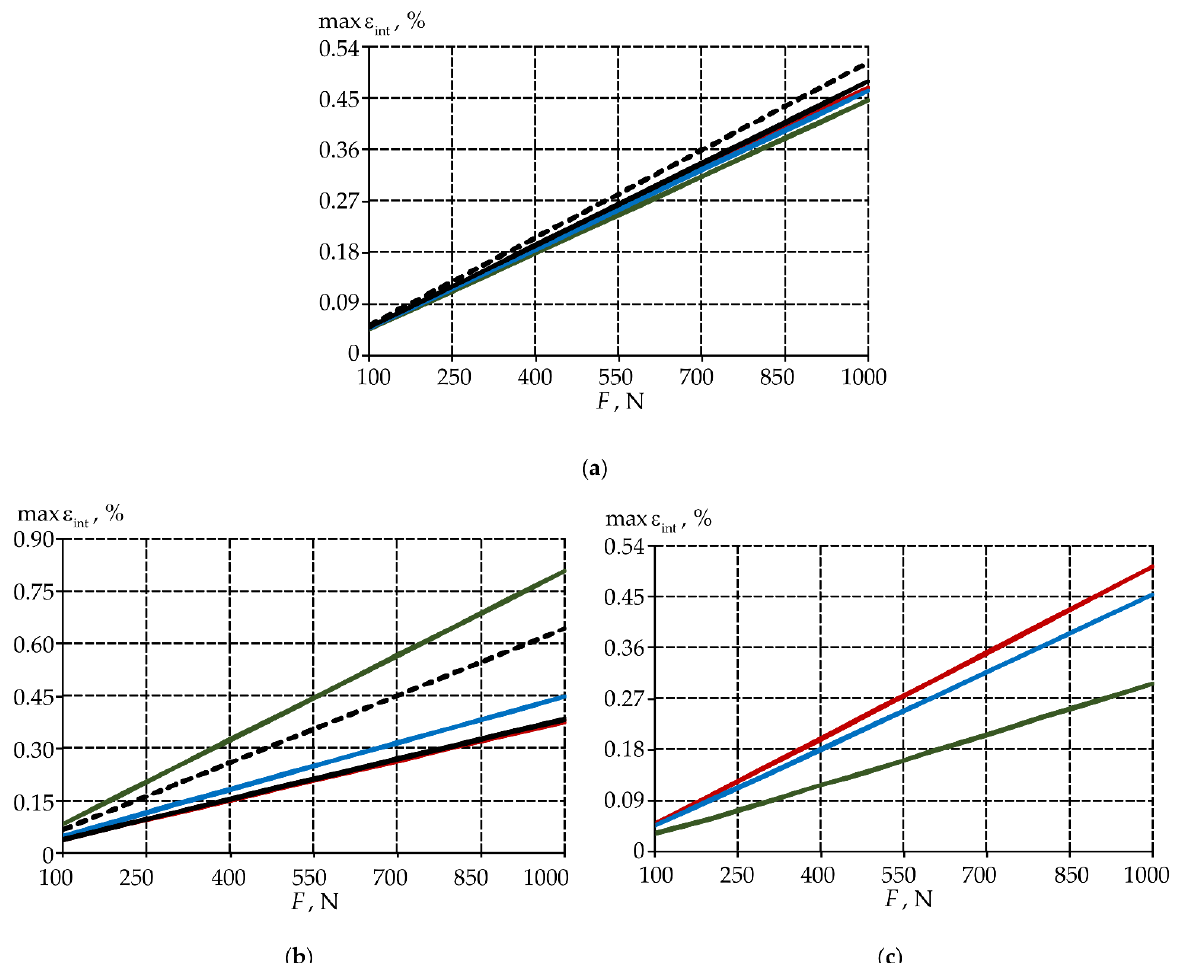
Figure 10. Dependence of the maximum values of the strain intensity of the biomechanical assembly on the load: ( a ) is enamel; ( b ) is dentine; ( c ) is inlay; black (solid line) is model without defect; black (dotted line) is model with defect; green is model with material 1 inlay, red is model with material 2 inlay, blue is model with material 3 inlay.